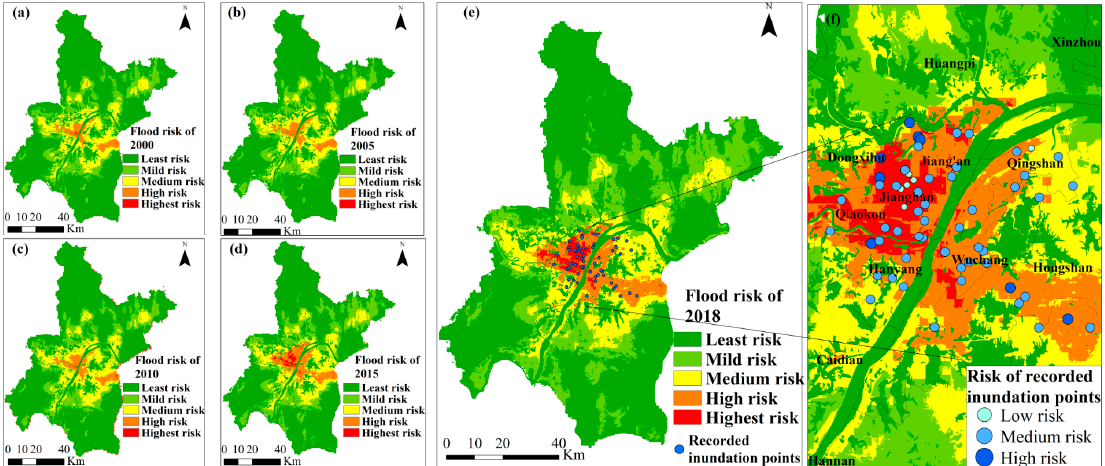
Figure 8. Spatial distributions of flood risk (( a ) 2000, ( b ) 2005, ( c ) 2010, ( d ) 2015, ( e ) 2018) and recorded inundation points in